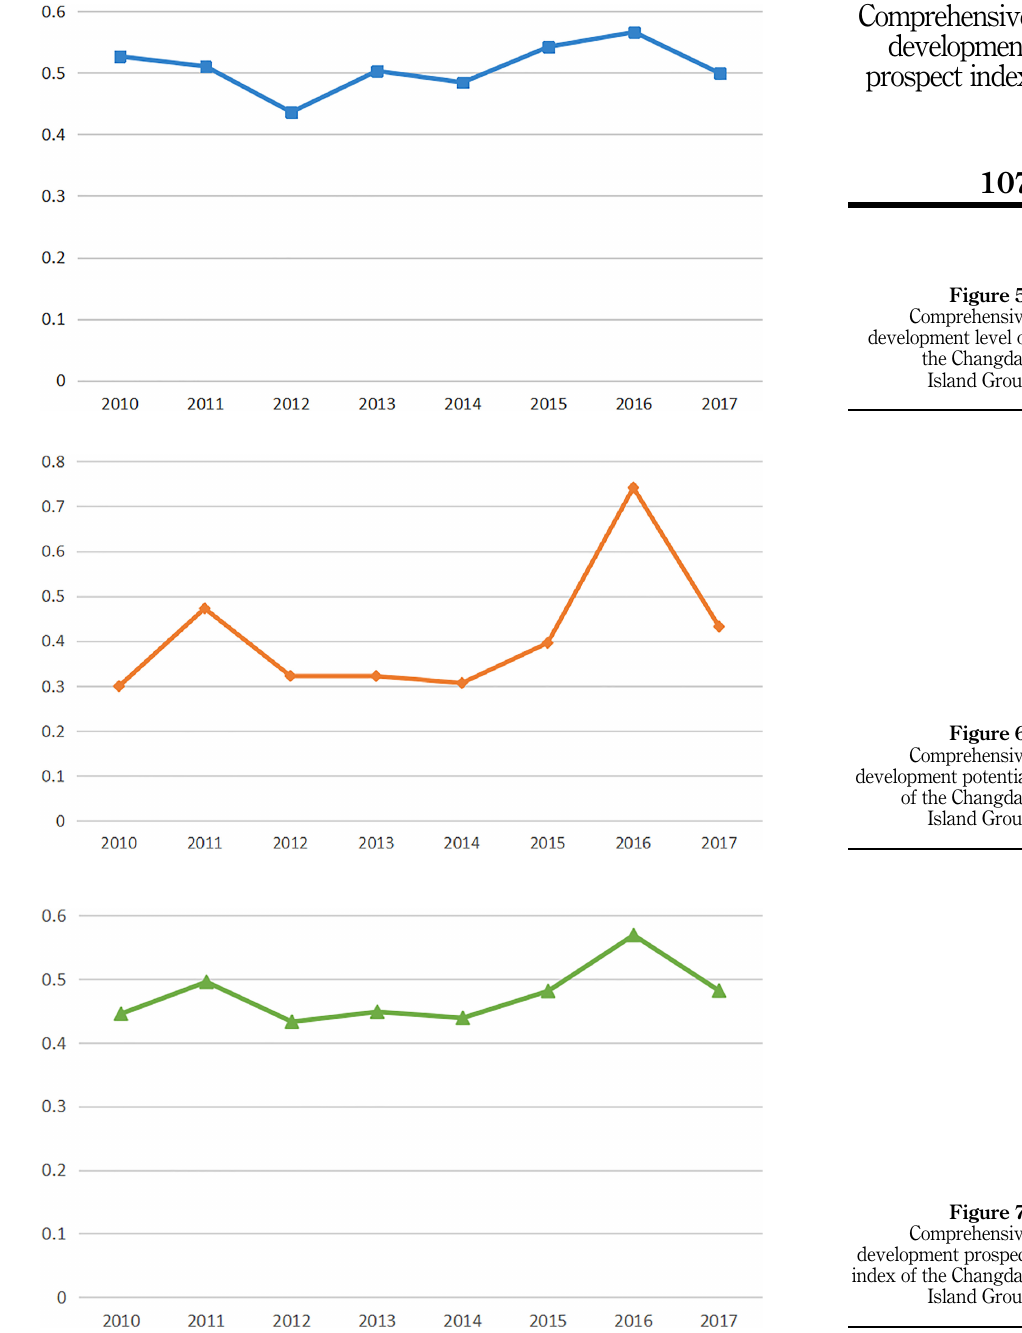
Figure 5. Comprehensive development level of the Changdao Island Group